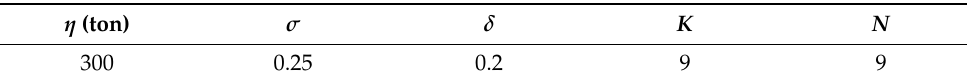
Table A5. Parameters of LCT and